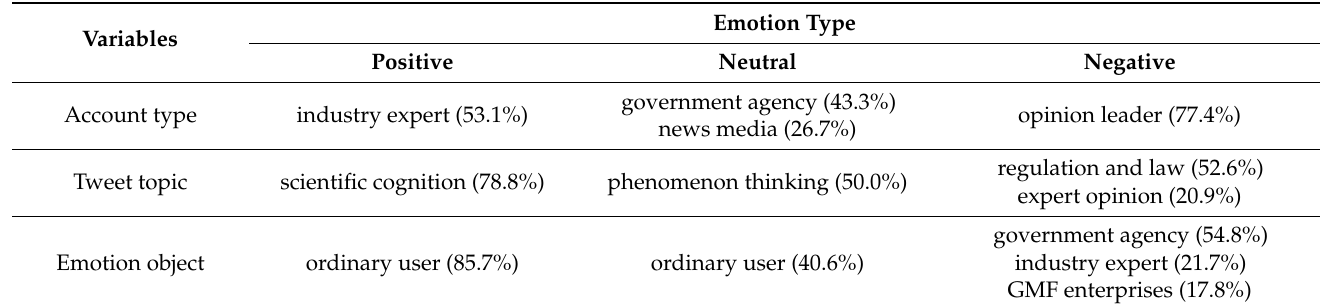
Table 3. Cross-analyses of emotion type ( n =